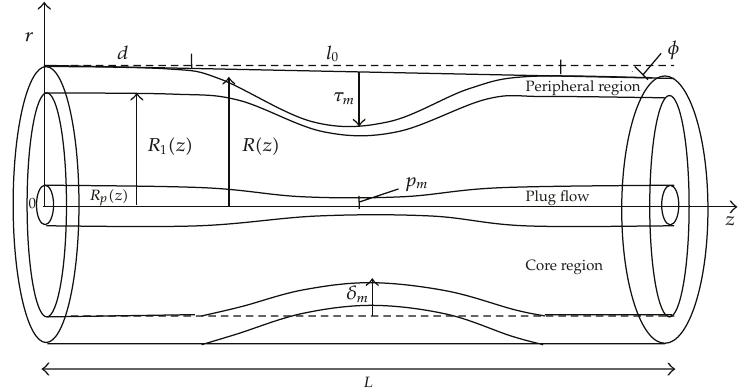
Figure 1: Geometry of the tapered stenosed arterial segment with peripheral